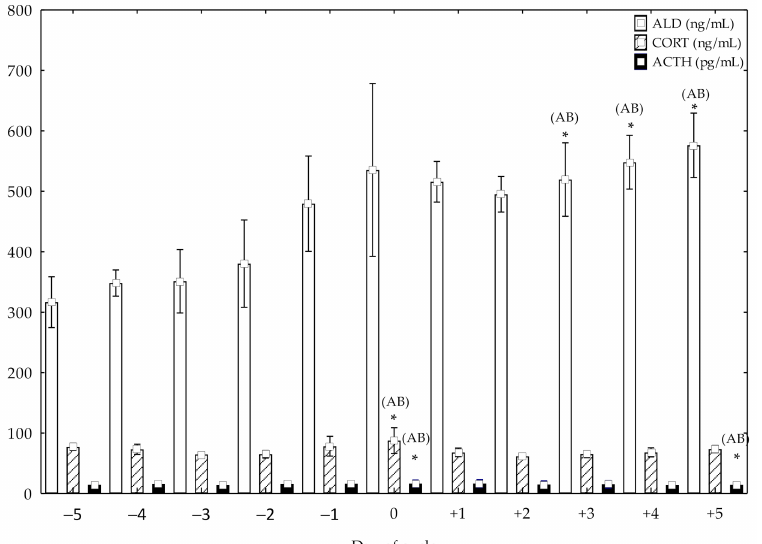
Figure 1. Adrenocorticotrophic hormone (ACTH), cortisol (CORT) and aldosterone (ALD) concen- trations (mean ± SD) in cycling mares (n = 23) from day − 5 pre-ovulation to day 5 post-ovulation. * Significant differences (A: vs. pre-ovulation days ( p < 0.05); B: vs post-ovulation days ( p < 0.05)). Na + and Cl − showed higher concentrations at day 0, compared to pre-ovulation day − 4 ( p < 0.05) and post-ovulation day +5 ( p < 0.05). K + showed higher concentrations at day +1 compared to day − 1 ( p < 0.05) (Table